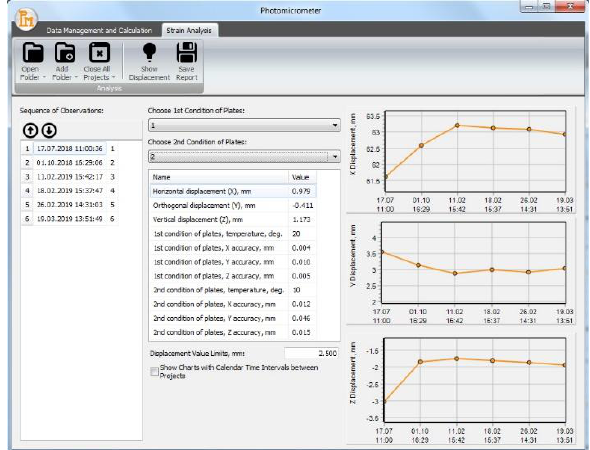
Figure 11. Computation and visualization of deformations over several observation